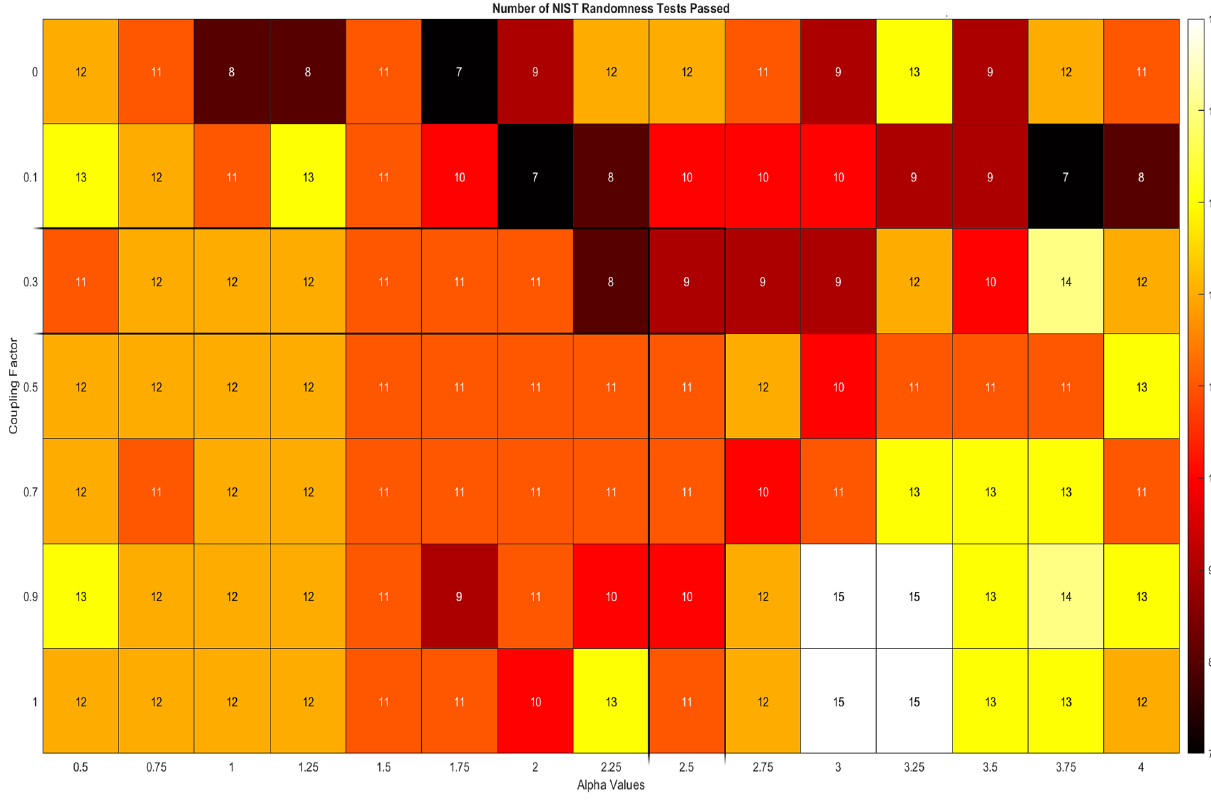
Fig. 12 Shows the number of NIST randomness tests passed by the proposed system with hundred lattice points and the parameters ( n = 100,000, t = 1000, N = 100, 𝛾 = 0.025, 𝛼 = [0.5, 4], 𝜖 = [0, 1]) Table 4 Time taken by proposed PRNG to generate pseudo-random sequences on resource constrained IoT devices based on increasing number of iterations and lattice